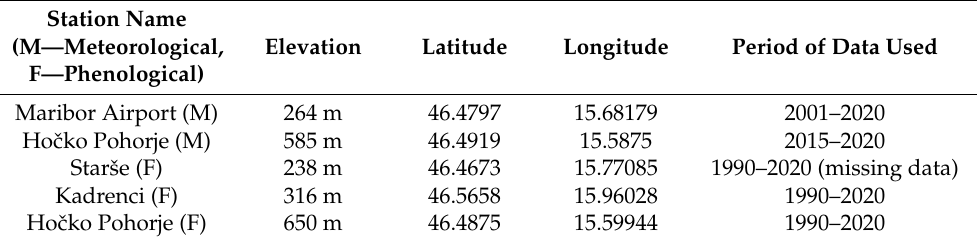
Table 2. Meteorological and phenological stations in the vicinity of the selected